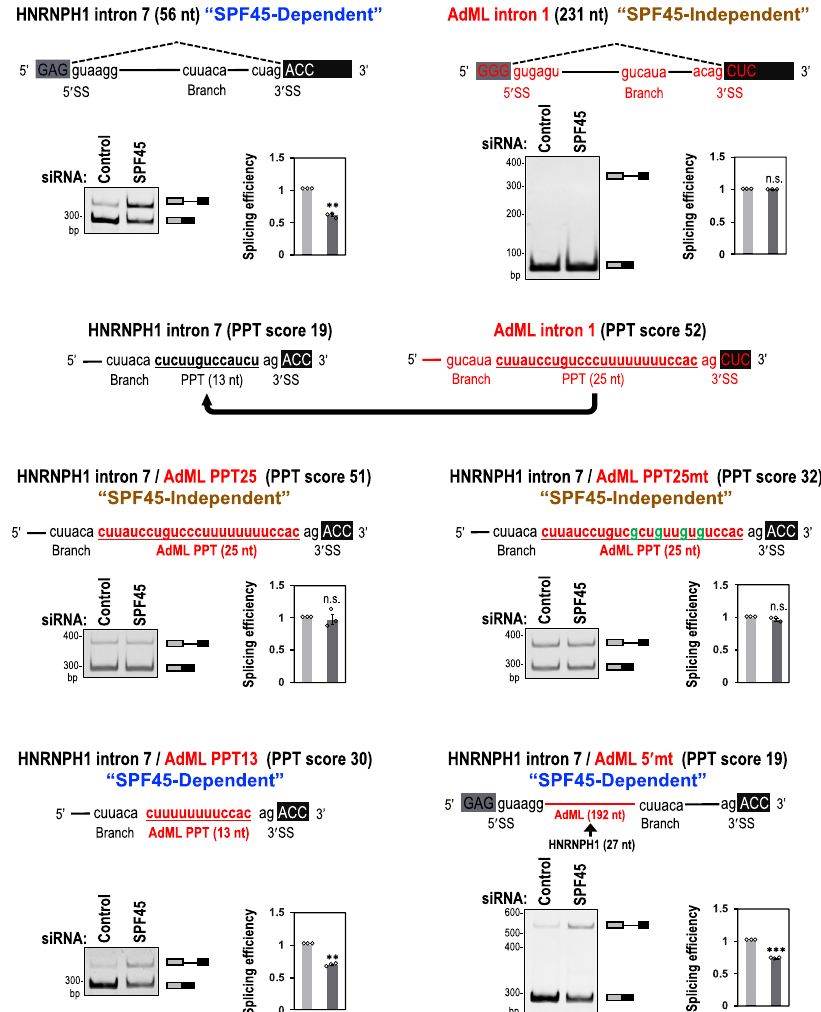
Fig. 3 The length of poly-pyrimidine tracts (PPTs) determine the SPF45 dependency of splicing. Original HNRNH1 and AdML pre-mRNAs and chimeric HNRNH1 pre-mRNAs are schematically shown (red color indicates AdML derived sequences). These pre-mRNAs were expressed from mini genes in HeLa cells and their splicing was assayed by RT-PCR. PAGE images and quanti fi cations of RT-PCR are shown. Means ± SEM are given for three independent experiments and two-tailed Student t -test values were calculated ( p = 0.0027 for Control siRNA vs SPF45 siRNA in HNRNPH1 intron, p = 0.9394 for Control vs SPF45 siRNA in AdML intron, p = 0.7548 for Control siRNA vs SPF45 siRNA in HNRNPH1 intron/AdML PPT25, p = 0.1961 for Control siRNA vs SPF45 siRNA in HNRNPH1 intron/AdML PPT25mt, p = 0.0011 for Control siRNA vs SPF45 siRNA in HNRNPH1 intron/AdML PPT13, p = 0.0004 for Control siRNA vs SPF45 siRNA in HNRNPH1 intron/AdML 5 ′ mt. ** P < 0.01, *** P < 0.001, n.s. P > 0.05. Source data of the above panels are provided as a Source Data fi